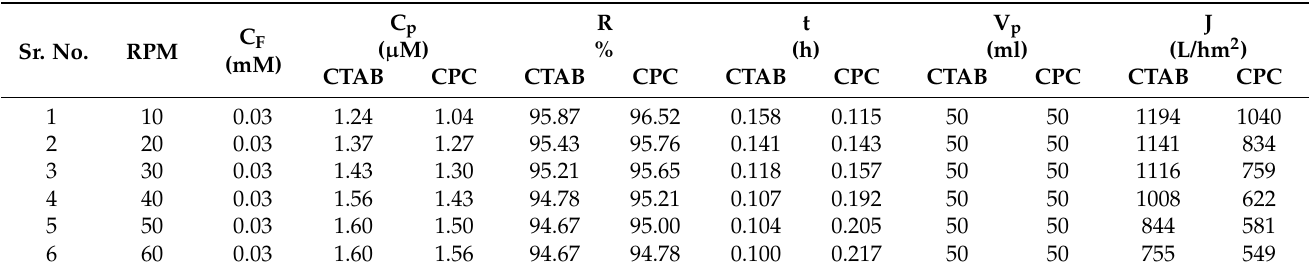
Table 6. Rejection coefficient, R%, and permeate flux, J, of Naphthol Green B for different values of RPM at fixed dye concentration, C F , dye concentration in permeate solution, C p , filtration time, t, permeate volume, V p